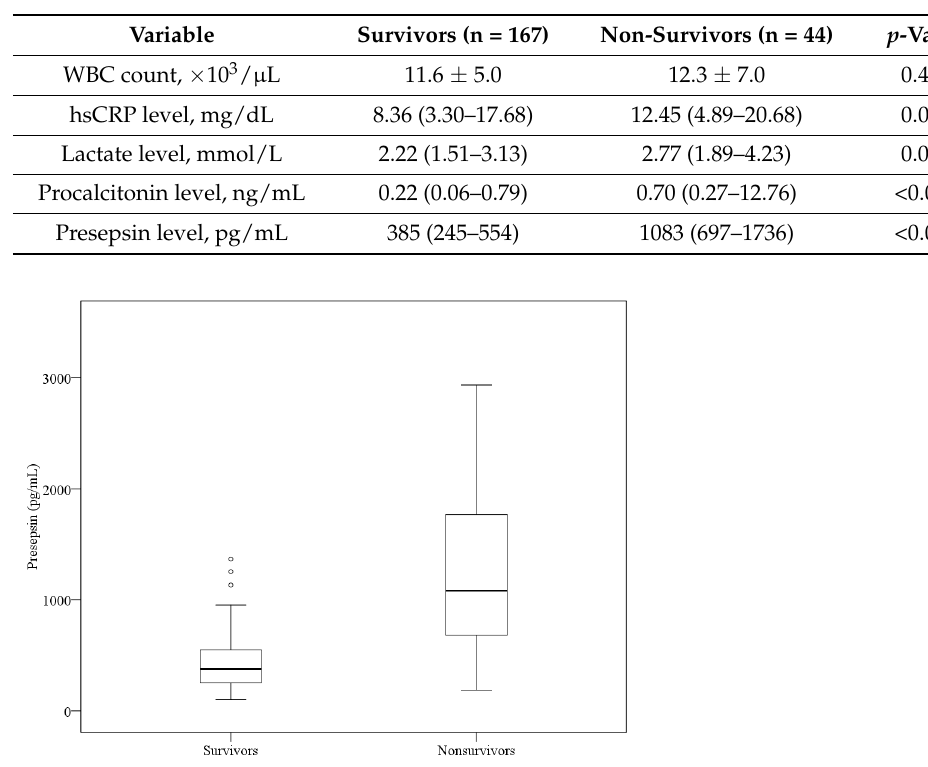
Table 3. Differences in laboratory results by survival status.